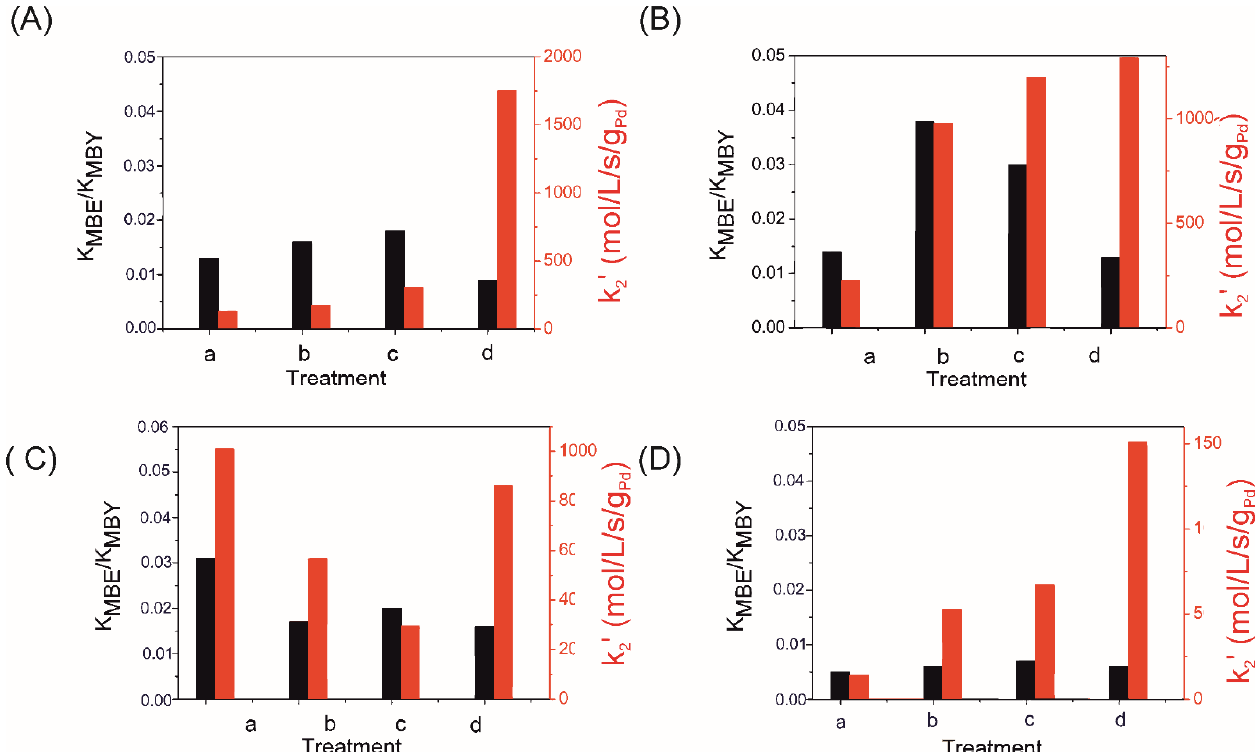
Figure 8. The effect of time on stream and activation conditions on kinetic constants in the hy- drogenation of MBY on coatings ( A ) PdZn/TiO 2 , ( B ) PdZn/Ti 0.8 Zr 0.2 O 2 , ( C ) PdZn/Ti 0.95 Ce 0.05 O 2 , ( D ) PdZn/Ti 0.8 Zn 0.2 O 1.8 . Black rectangle—K MBE /K MBY and red rectangle—k 2